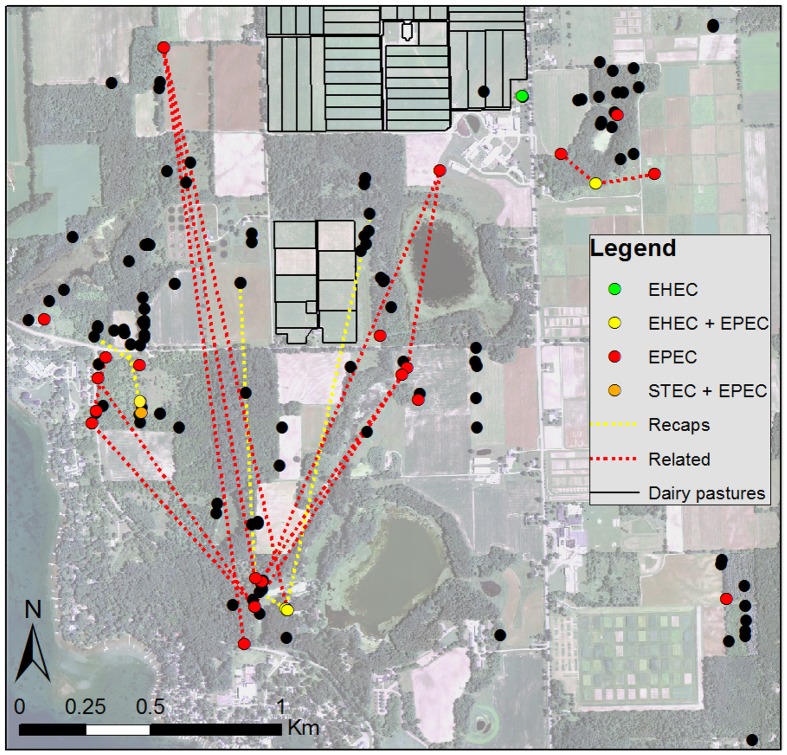
Aerial photo of the study site showing locations of deer feces (black dots) and feces positive for one of three diarrheagenic E. coli pathotypes (colored dots). Yellow lines connect fecal groups of the same deer determined from multi-locus genotyping collected during different seasons, including the 12 individual animals that acquired a pathogen over time. Red lines connect fecal groups of genetically related deer (parent-offspring or full siblings) that have moved within the agroecosystem.